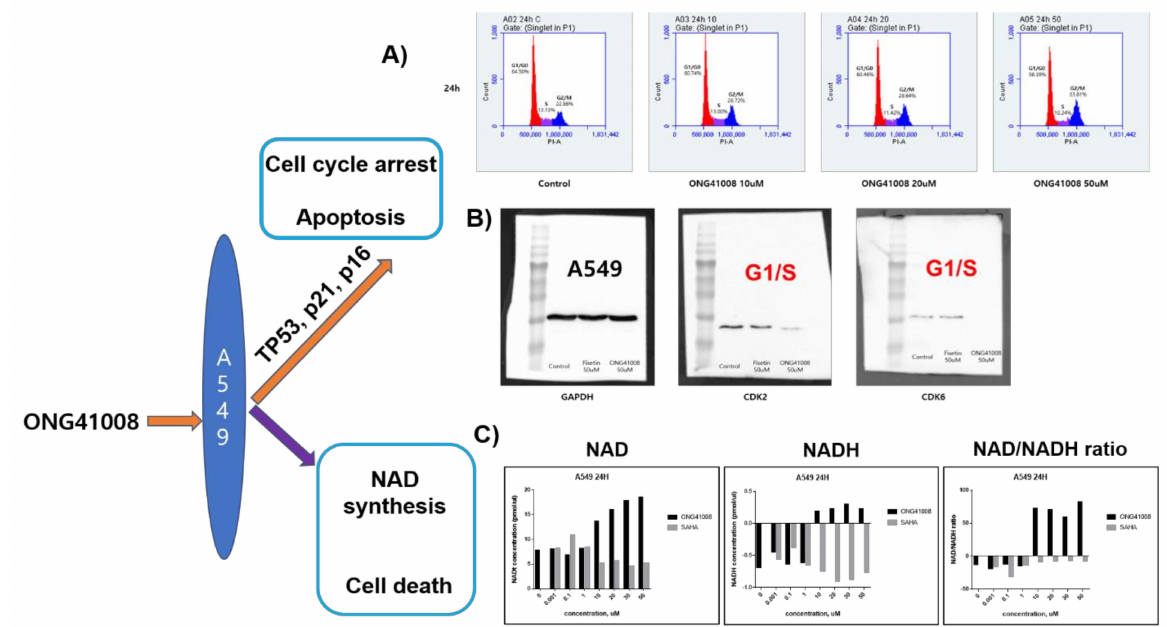
Figure 10. ONG41008-mediated cell-cycle arrest and induction of NAD/NADH and ROS expression ( A ) A549 cells were stained by PI. Cell cycle analysis was performed by FACS. ( B ) A549 cells were stimulated with 50 µ M fisetin or ONG41008 for 24 h, and then cell lysates were collected. CDK2 and CDK6 expression was detected by Western blot analysis. ( C ) A549 cells were stimulated with medium alone, varying concentrations of SAHA or ONG41008 for 24 h. Cell lysates were prepared and the NAD/NADH ratio was measured. A representative NAD/NADH ratio was presented out of a total of six independent